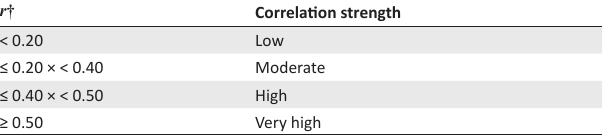
TABLE 4: Categorisation criteria for Pearson coefficients.